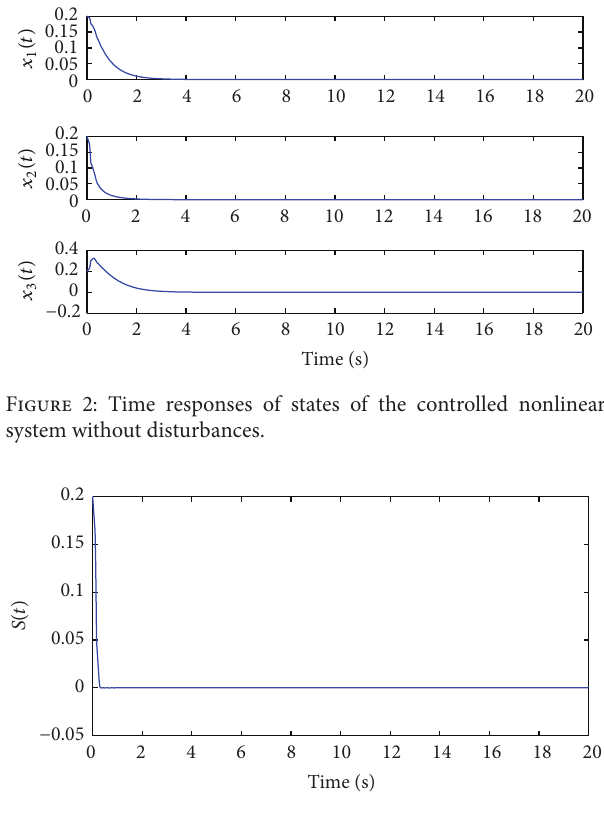
Figure 3: Time responses of switching surface 𝑆(𝑡) without distur-